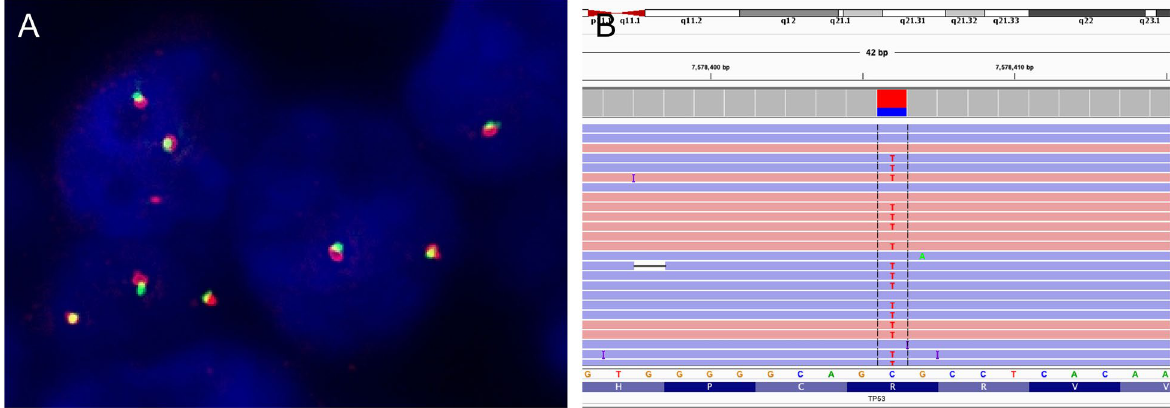
Fig. 4 FISH and DNA-based targeted sequencing. A FISH using a DEK break-apart probe revealed no DEK rearrangement. B IGV alignment of the TP53 R175H (c.524G >